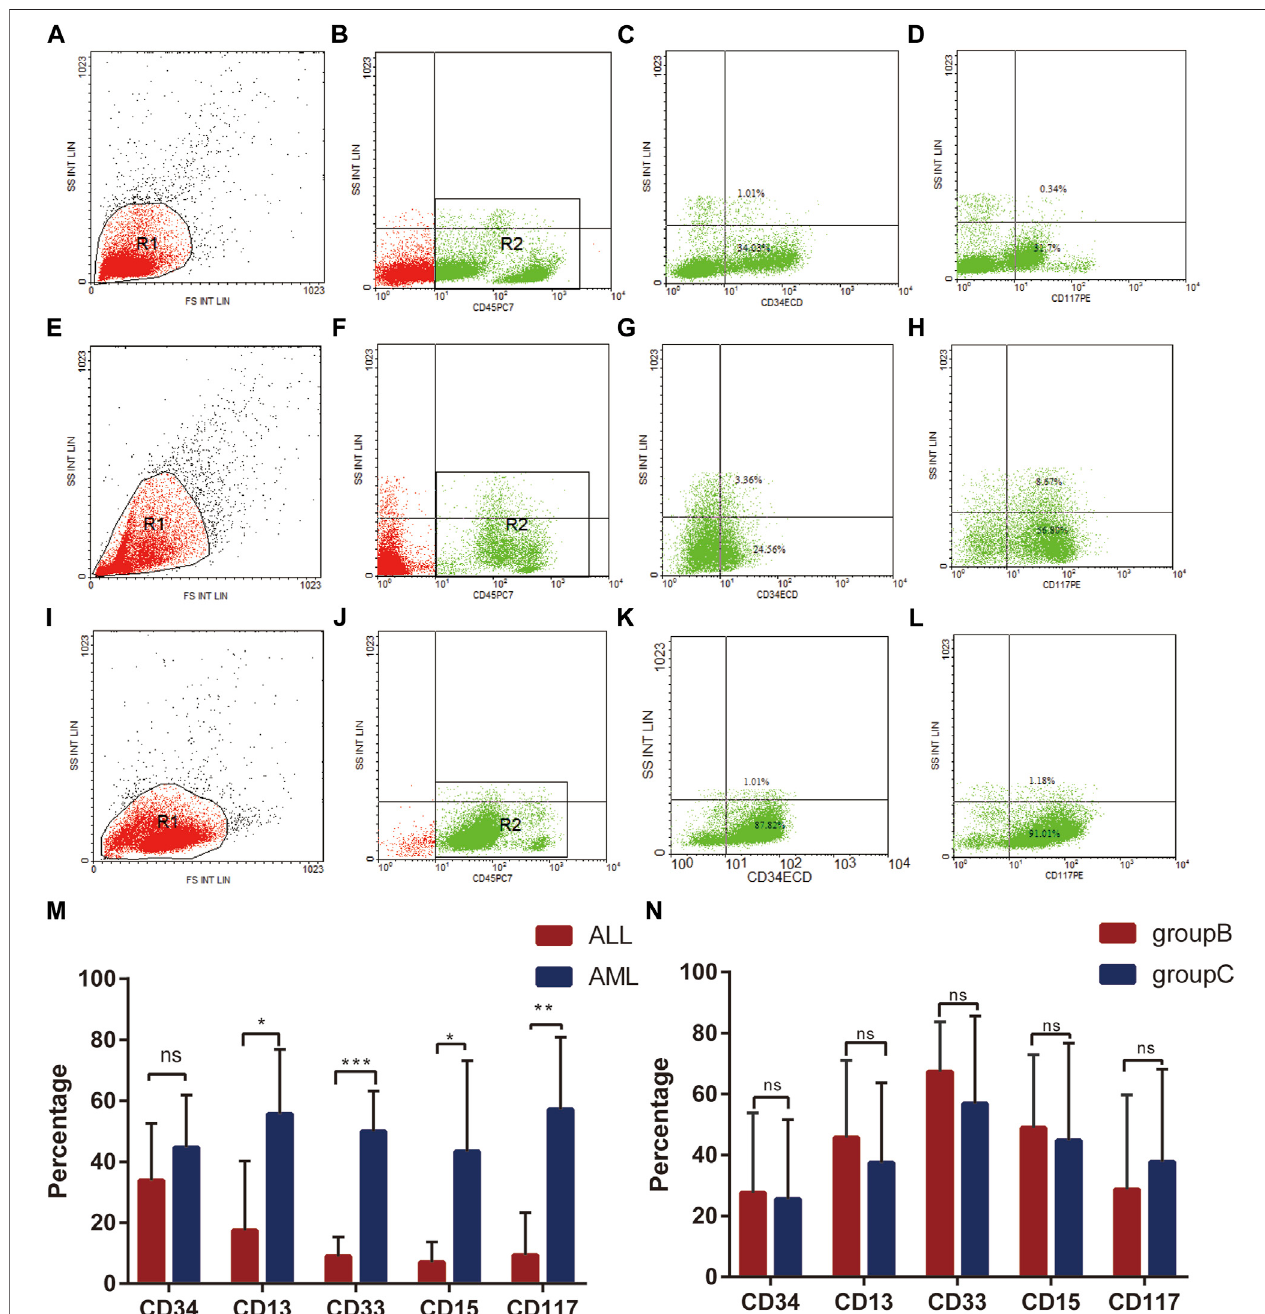
FIGURE 5 | Leukocyte surface antigen expression detected by fl ow cytometry. (A – D) : Expression of leukocyte surface antigen CD34 (C) , CD117 (D) in acute lymphoblastic leukemia (group A); (E – H) : Expression of leukocyte surface antigen CD34 (G) , CD117 H in acute myeloid leukemia (group B); (I – L) : Expression of leukocytesurfaceantigenCD34 (K) ,CD117 (L) inacutemyeloidleukemia(groupC); (M) :ExpressionofleukocytesurfaceantigensCD34,CD117,CD13,CD33,CD15in AML (group D) and ALL (group A). (N) : Expression of leukocyte surface antigens CD34, CD117, CD13, CD33, CD15 between AML groups (groups B and C).